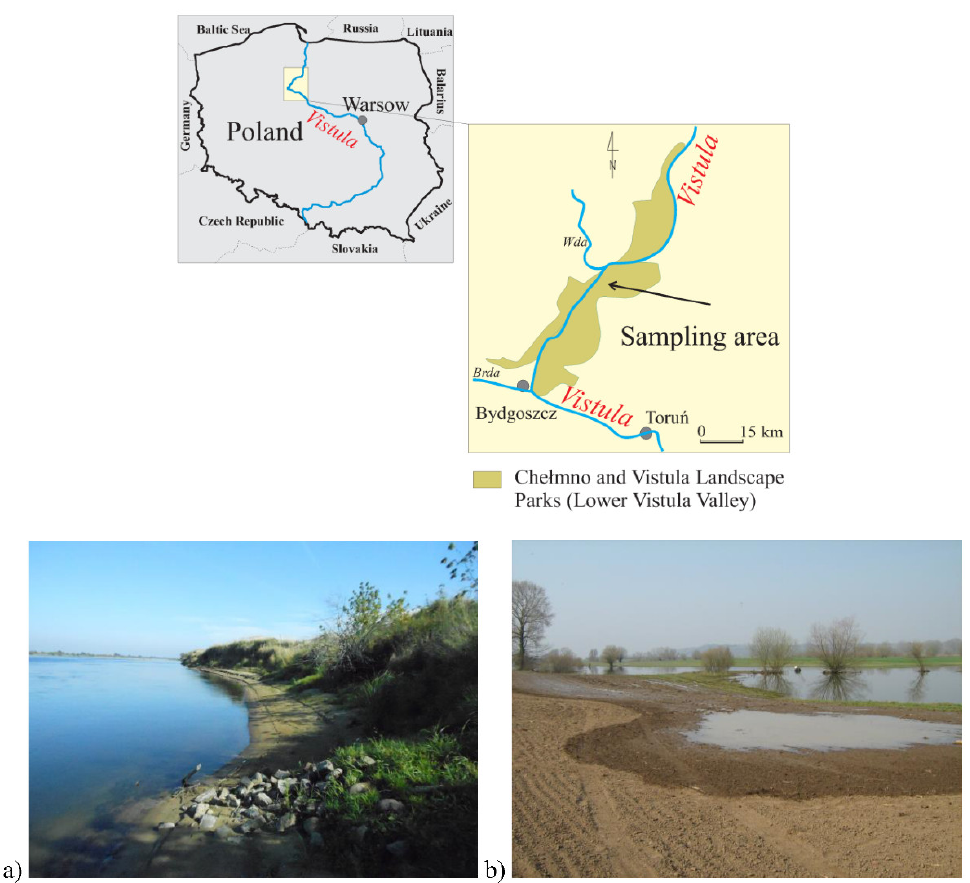
Figure 1. Schematic map and sampling places: ( a ) riverbank sediments; ( b ) floodplain. Fluvisol samples were collected using a spade from a depth of 0–30 cm in three replicates: ten samples were taken from arable soils and eight from grassland. The distance between the replications was 20 m in an equilateral triangle and soil samples were taken in a distance within a few kilometres (floodplain). Soil samples were packed into plastic